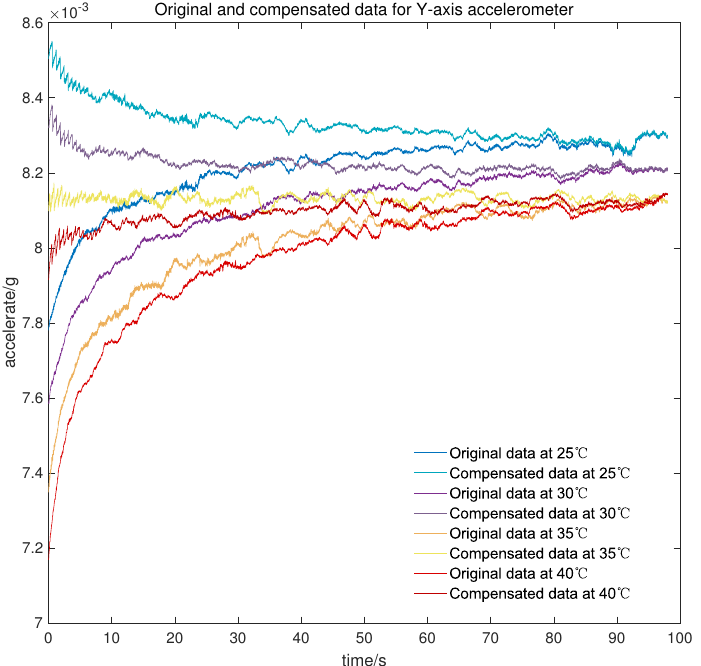
Figure 11. Original and compensated data for Y -axis accelerometer at different temperature